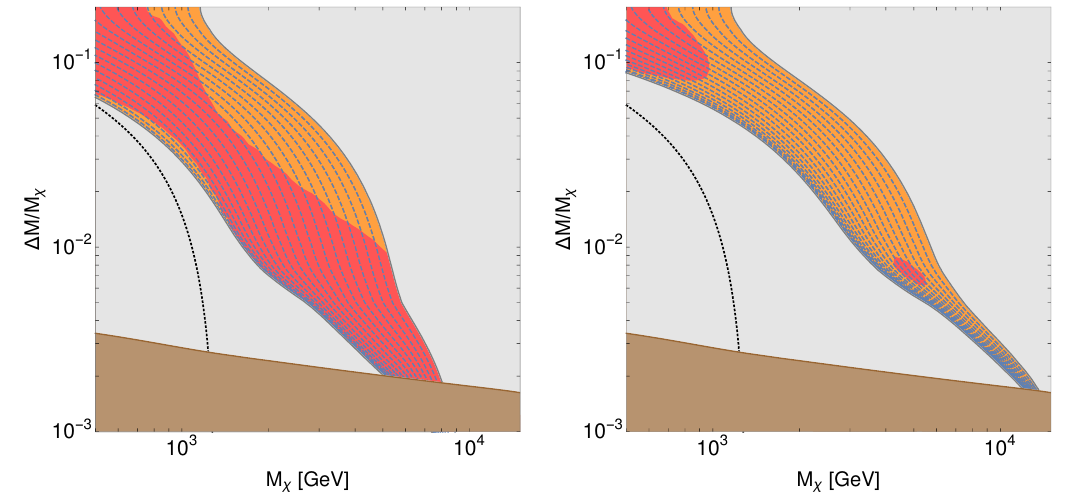
Figure 5 . The left (right) panel summarized constraints on a thermally produced DM coupling to u -quarks via a coloured mediator (cid:17) for (cid:21) 3 = 0 : 0 ( (cid:21) 3 = 1 : 5). The red region is excluded by results of the Xenon1T experiment. The orange region shows the part of parameter space which can be tested by a future Darwin-like direct detection experiment. In the upper gray area y (cid:21) 2 is required to reproduce the correct relic abundance. In the lower gray region the thermal abundance is controlled exclusively the gauge interactions and the observed relic abundance can not be achieved for DM from freeze-out. In the brown region, twice the mass splitting is smaller than the binding energy of the lightest (cid:17)(cid:17) y bound state. The dashed blue lines indicate the required value of y while the dotted black line indicates results obained with the in-vacuum cross section and y = 0 : 3. is reached. On the other side, for low (cid:1) M=M (cid:31) coannihilations become very e(cid:14)cient